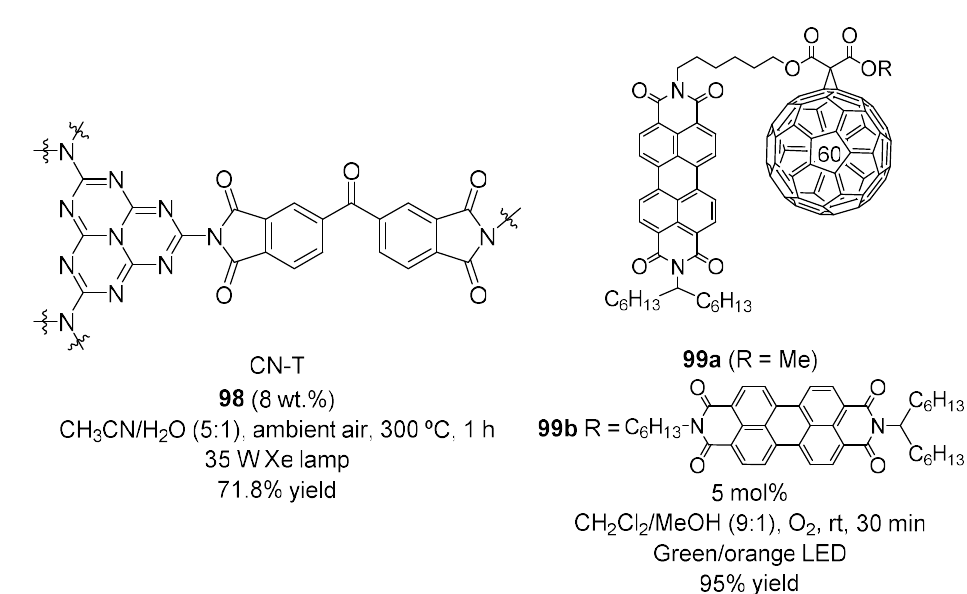
Figure 30. Results of the aerobic photo-oxidation of 1,5-dihydroxynaphthalene to Juglone ( 85 : R 1 = R 2 = R 5 = H, R 4 = OH) catalyzed by 98 and 99 .